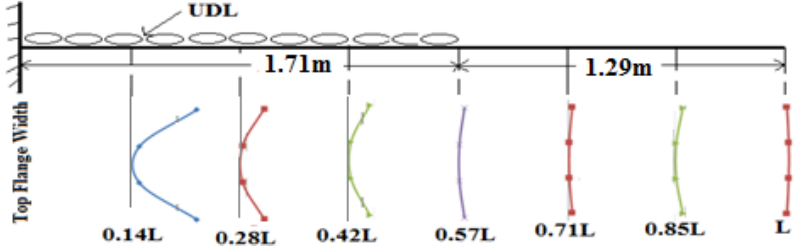
Figure 3. Top flange deformation in the longitudinal direction.